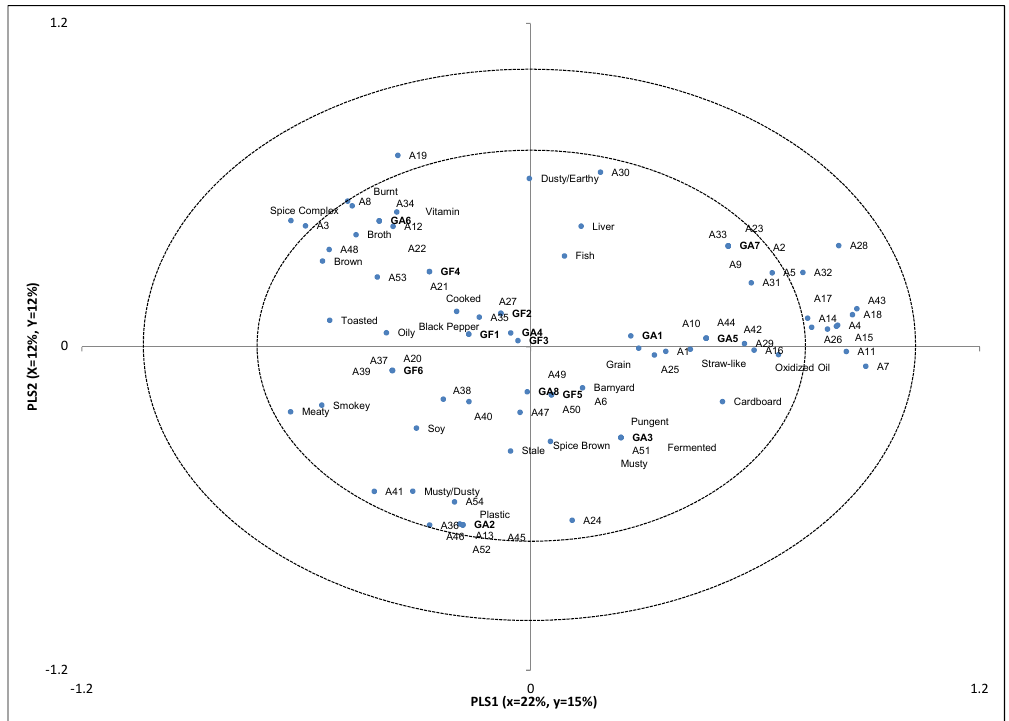
Figure 1. Partial Least Squares Regression factors 1 and 2.